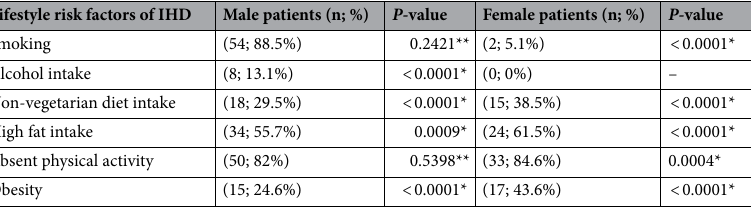
Table 5. Lifestyle risk factors presented in IHD patients. *Significant correlation ( p ≤ 0.05). **No significant correlation ( p > 0.05).